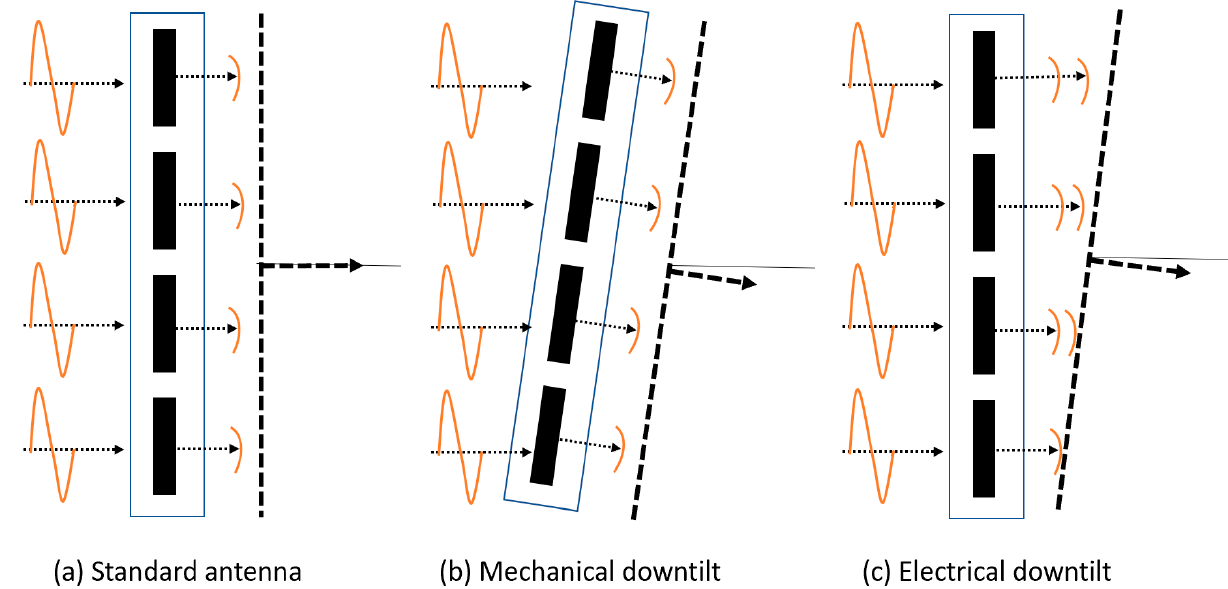
Figure 23. Types of antenna downtilt.